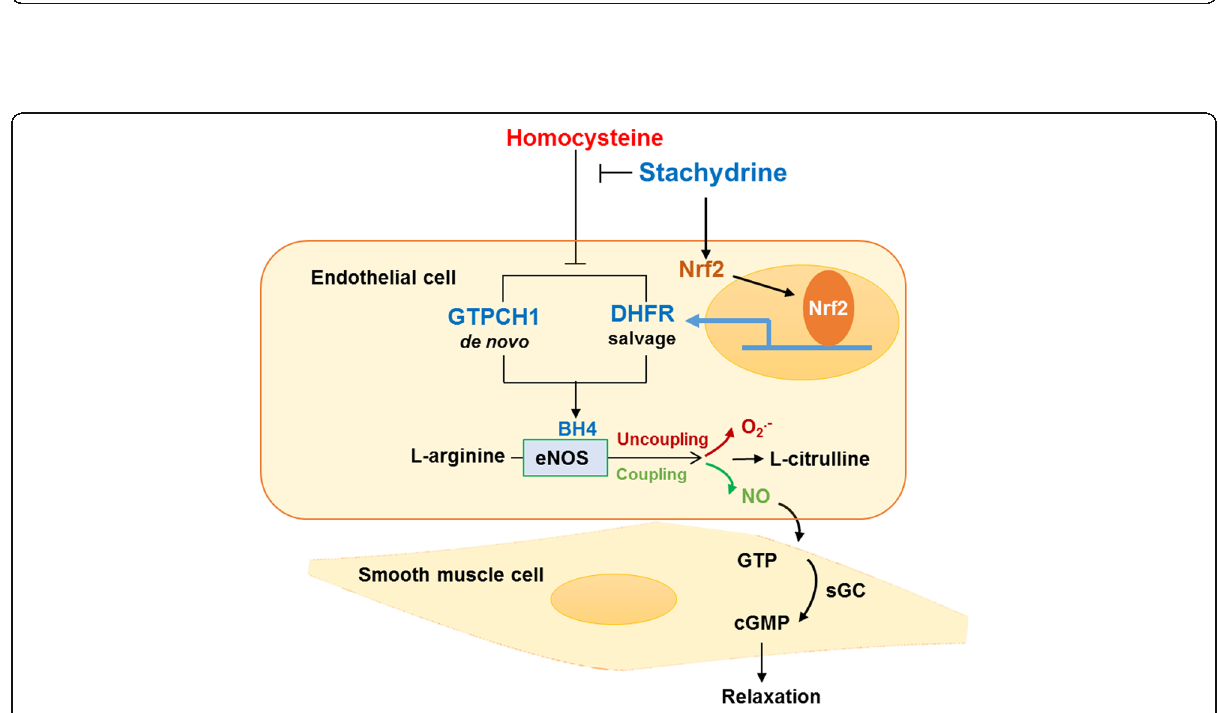
Fig. 7 Schematic model of the effect of STA on Hcy-induced endothelial dysfunction. Stachydrine ameliorated Hcy-induced endothelial dysfunction via Nrf2-dependent up-regulation of GTPCH1 and DHFR. The de novo synthesis and salvage of BH4 reversed eNOS uncoupling and increased NO production, thus, leading to improved endothelium-dependent